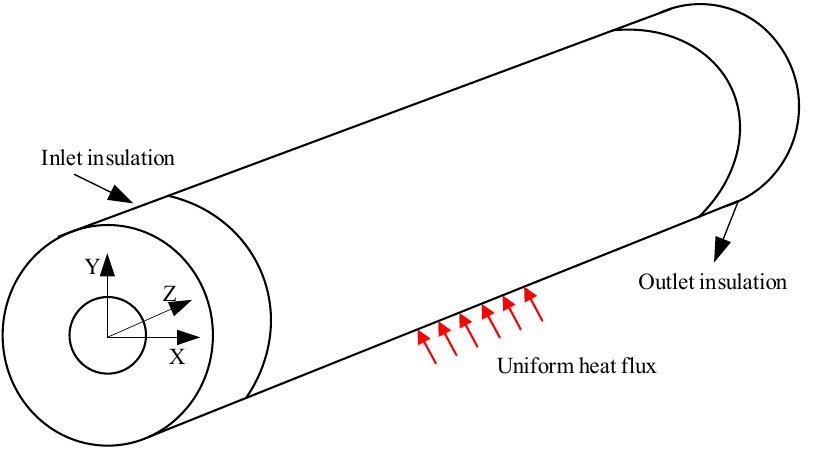
Figure 3. Schematic diagram of the cooling channel.